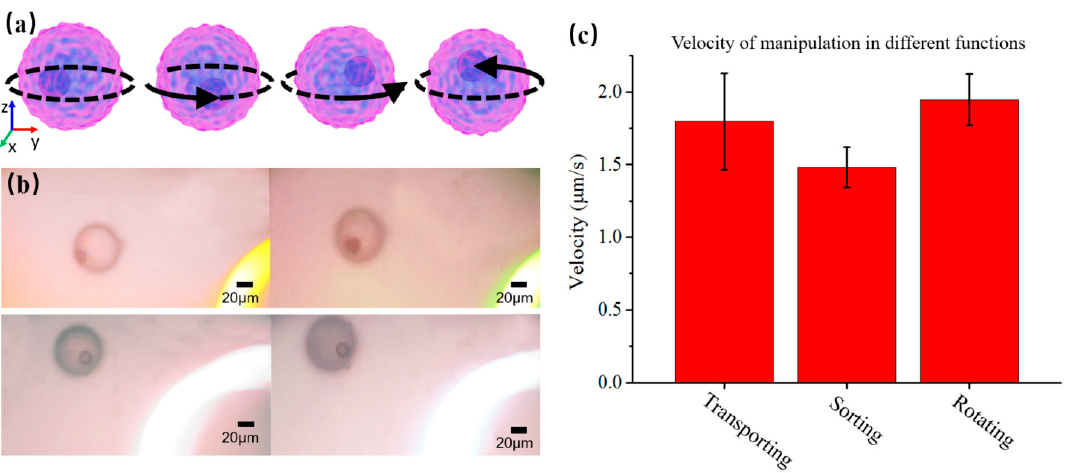
Figure 12. Rotating the microparticle via OET. ( a ) Schematic of rotating microparticle; ( b ) Images of rotating microparticle in the buffer medium; ( c ) Velocity of manipulation in different functions.